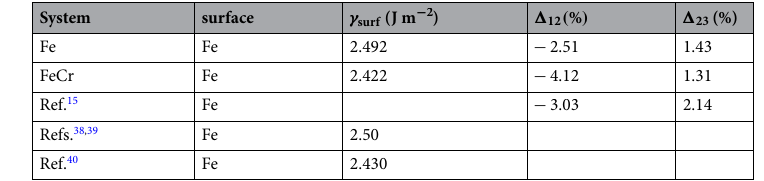
Table 1. Surface energies and relaxations of the first two surface layers of the investigated systems. The system label ‘Fe’ indicates that the lattice constant of pure Fe (dilute alloy) is used; ‘FeCr’ indicates the lattice constant of the Fe 0.91 Cr 0.09 alloy. Here (cid:31) 12 is the percentage change in the distance between the surface layer and the first subsurface layer, relative to the layer distance in bulk, and (cid:31) 23 is the percentage change in the distance between the first and second subsurface